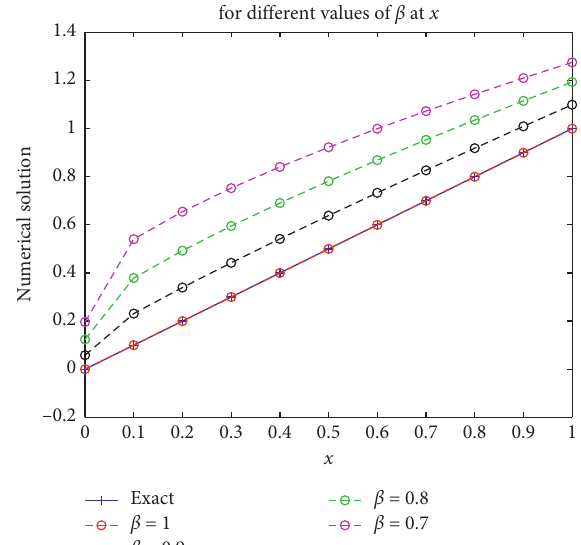
Figure 3: The numerical solutions for different fractional orders β are depicted corresponding to Problem